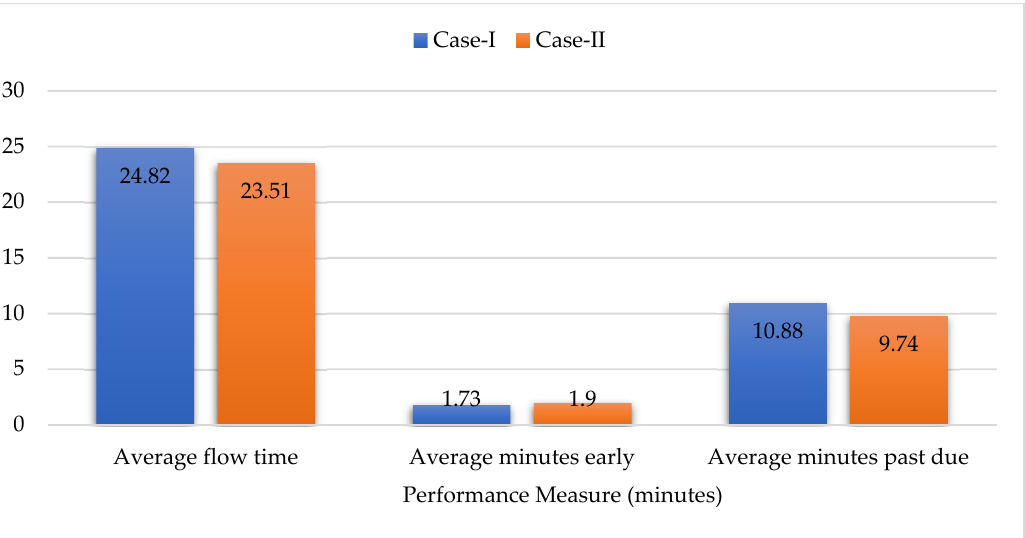
Figure 9. Comparison of the performance measures for Case-I and Case-II the using FCFS rule. Keeping promises to customers, the SPT rule provided better results than the EDD and FCFS rules with respect to average minutes past due and average flow time while the FCFS rule produced better results than the EDD and SPT rules with respect to average minutes early. As the management prefers improving the average minutes past due over the other performance measures, the SPT sequencing rule was used. 8. Conclusions In this article, mathematical models for two settings (Case-I and Case-II) of an Indus- try 4.0-based yogurt filling system were developed and compared. The objectives of the models were the conveyor belt speed maximization or minimizing the processing time on an order or maximizing the throughput. In Case-I, the filling processes were performed at two different locations, while in Case-II, the filling processing was performed at a single location. The decision variables were the feed rates of the yogurt and flavor valves, and these variables controlled the speed of the conveyor belt.